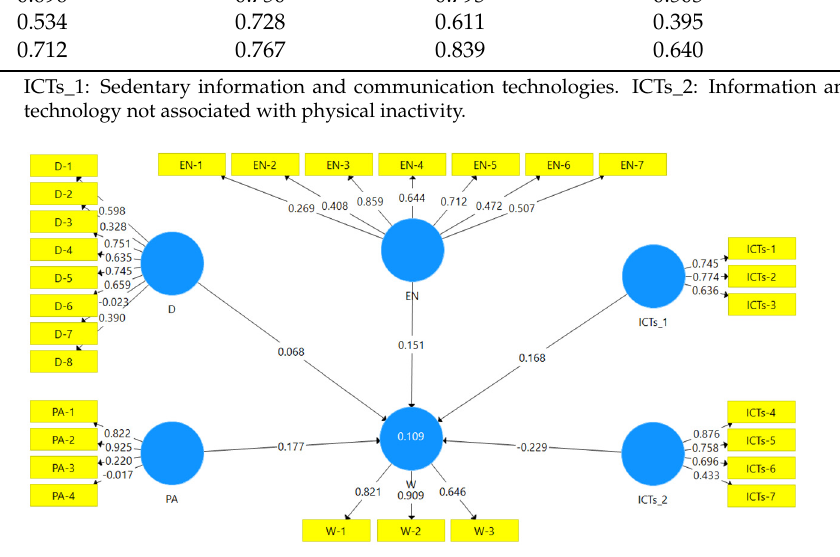
ICTs_1: Sedentary information and communication technologies; ICTs_2: Information and commu ‐